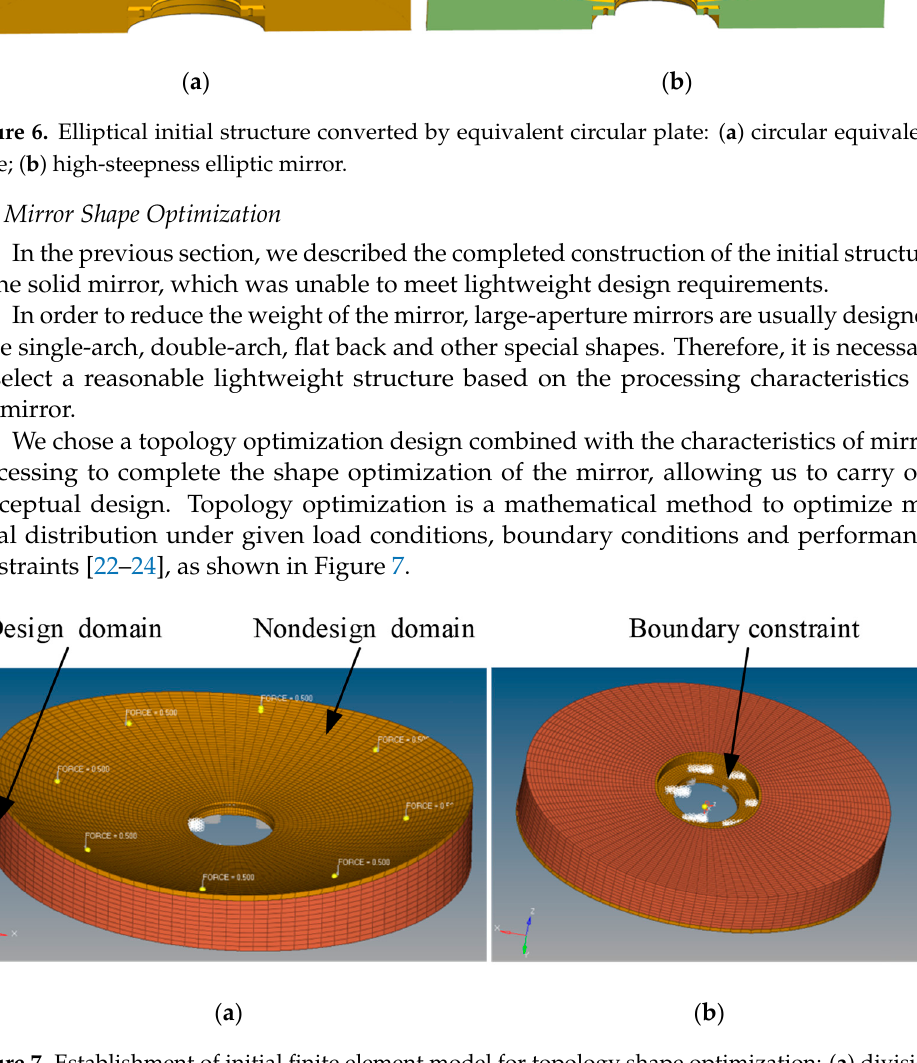
Figure 6. Elliptical initial structure converted by equivalent circular plate: ( a ) circular equivalent plate; ( b ) high-steepness elliptic mirror. plate; ( b ) high-steepness elliptic mirror.